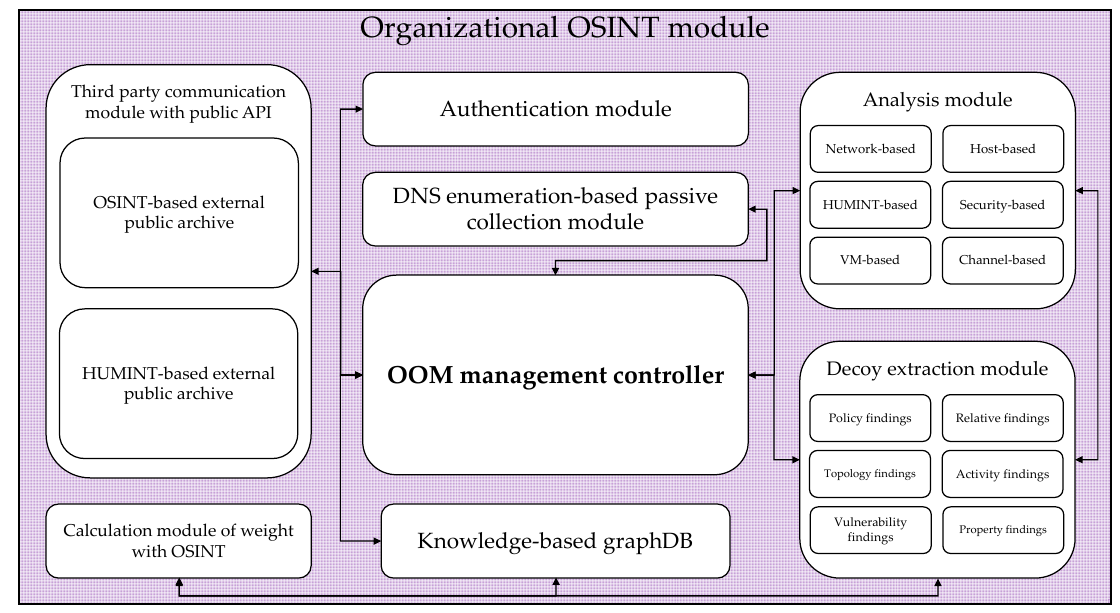
Figure A2. GraphDB-based organizational OSINT module in Figure 4.